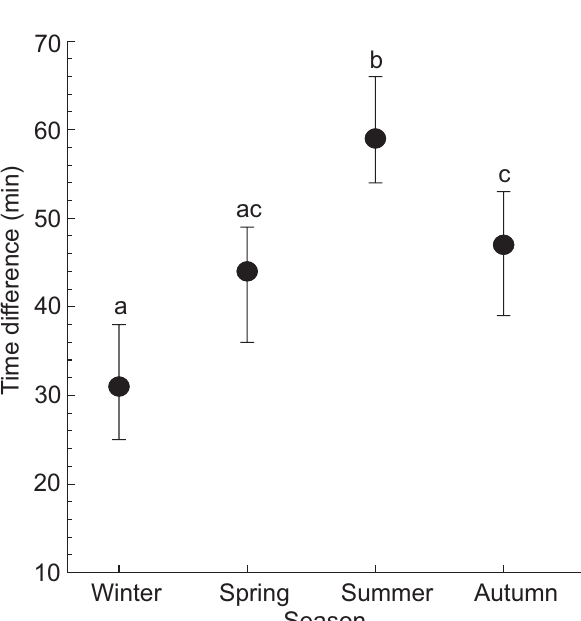
Figure 5. Linear regresion between time of sunset and time of first calling male of Hypsiboas leptolineatus .